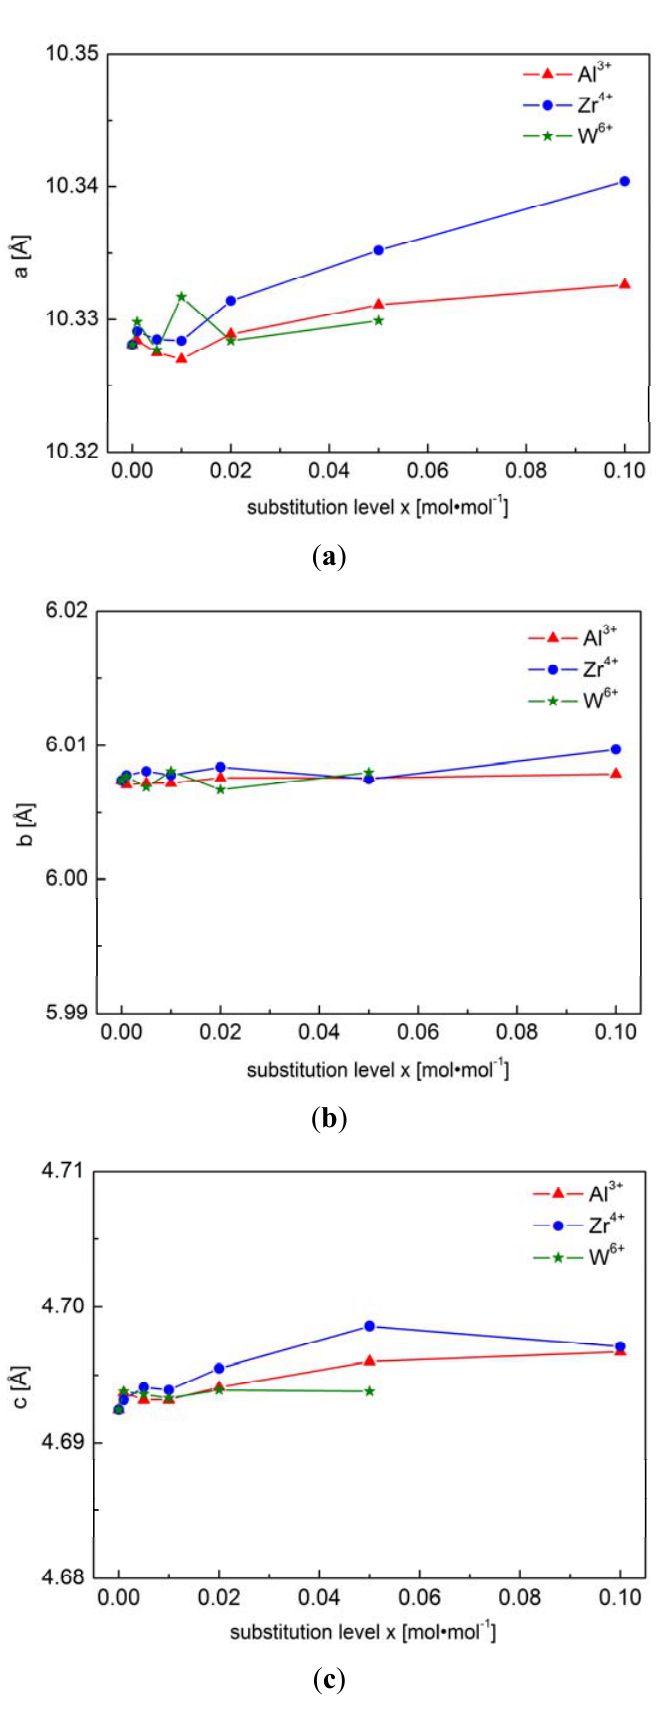
Figure 2. Unit cell parameters a , b and c for Li W FePO materials Li 1 − 6 x x 4